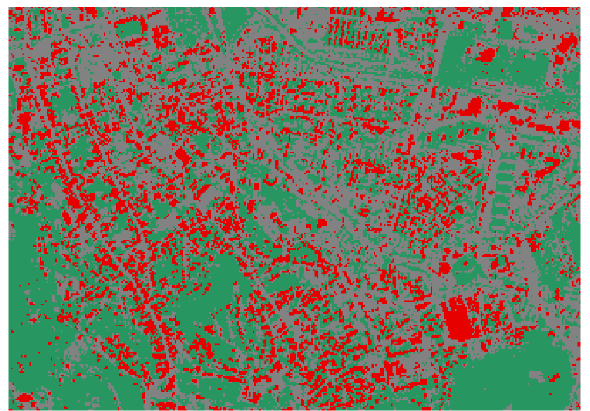
Figure 4 . Classified image for year 2021